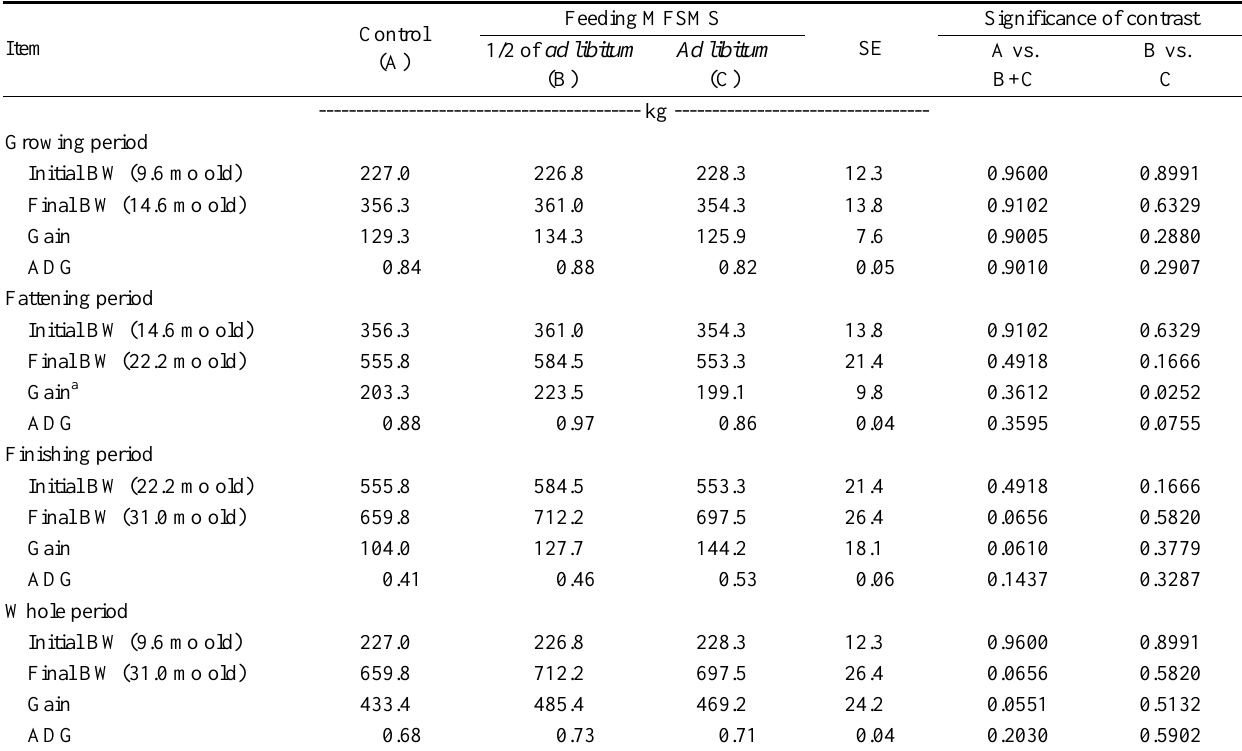
Table 3. Effect of dietary supplementation of microbially-fermented spent mushroom substrates (MFSMS) on growth performance of Hanwoo steers 1